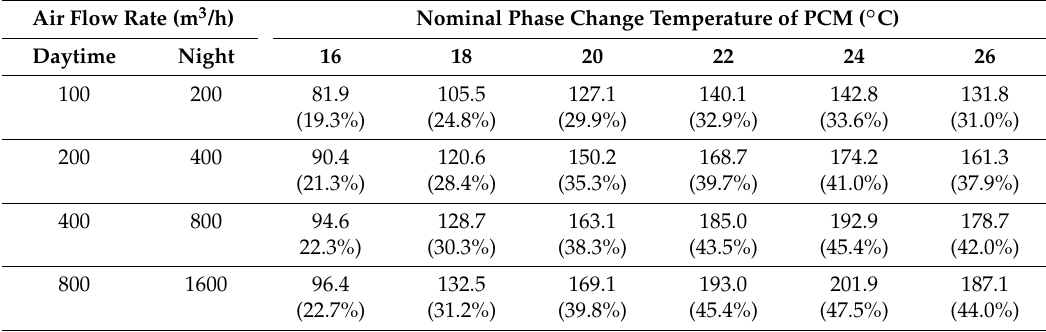
Table 7. Energy saving potential (ESP) in kWh for Madrid at various air flow rates without the temperature set point. The percentage in brackets is URHF.